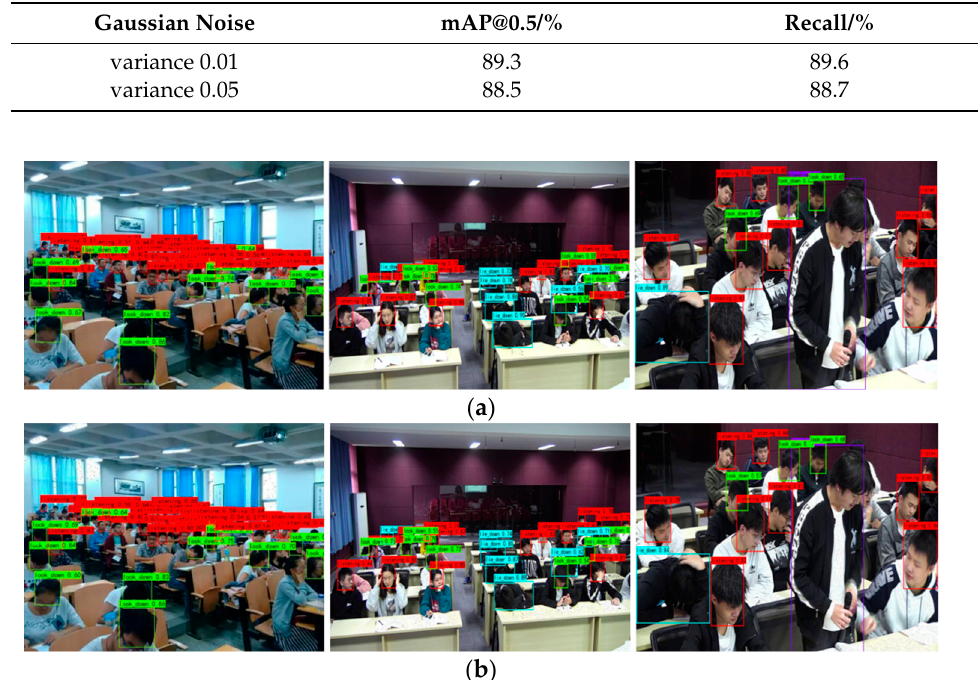
Table 5. Detection results after adding different variance noises.